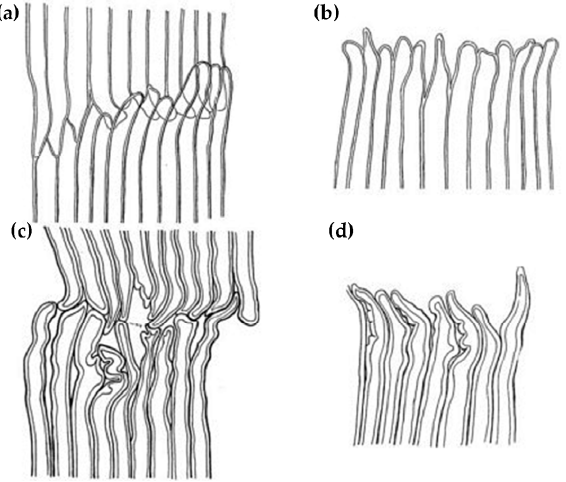
Figure 6. Normal wood tracheids ( a , b ) and compression wood tracheids ( c , d ) [53].